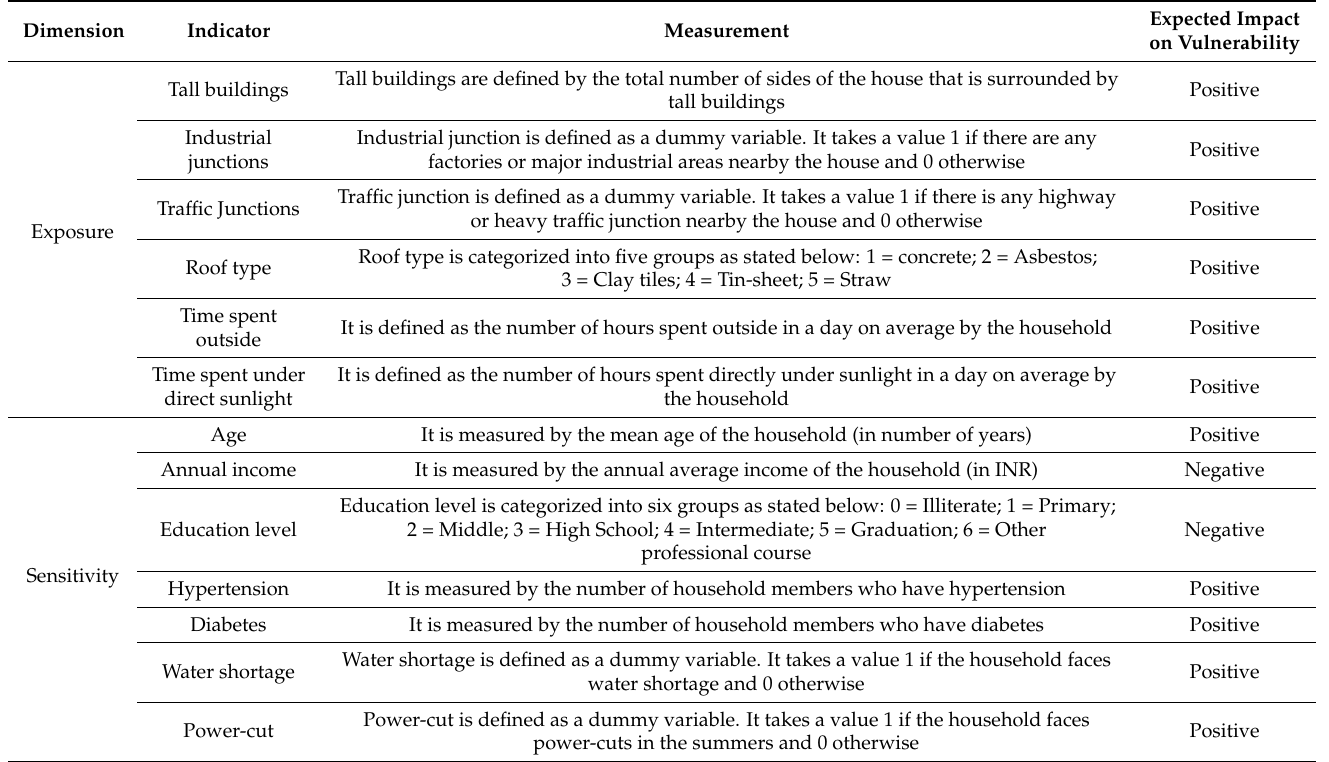
Table 1. Description of variables and expected impact on